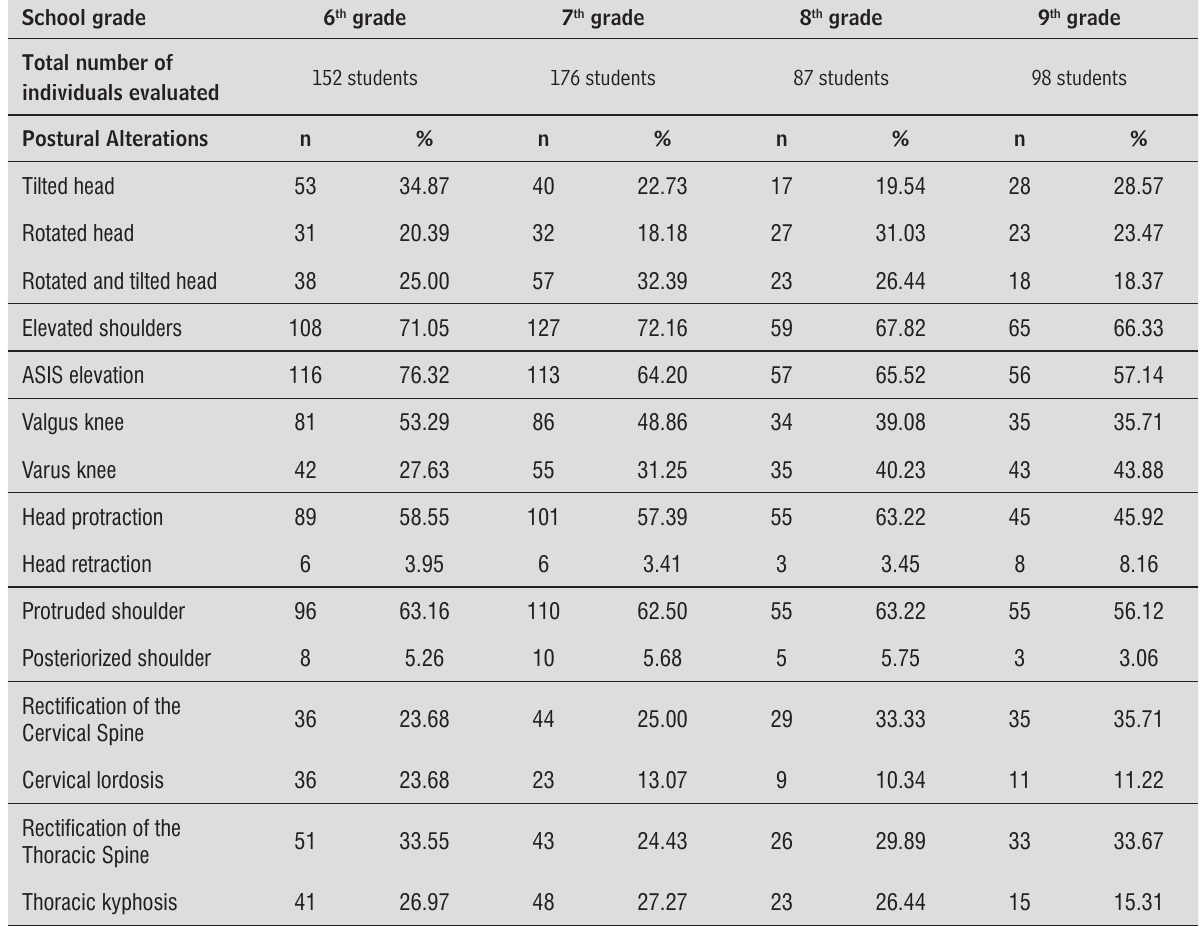
Table 4 - Frequency of postural alterations per school